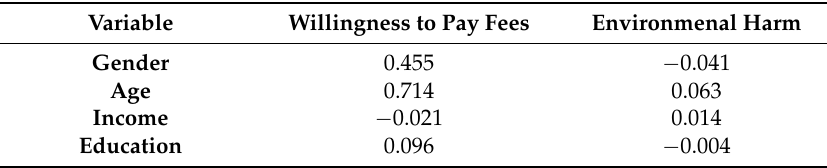
Table 4. General perception of environmental handling